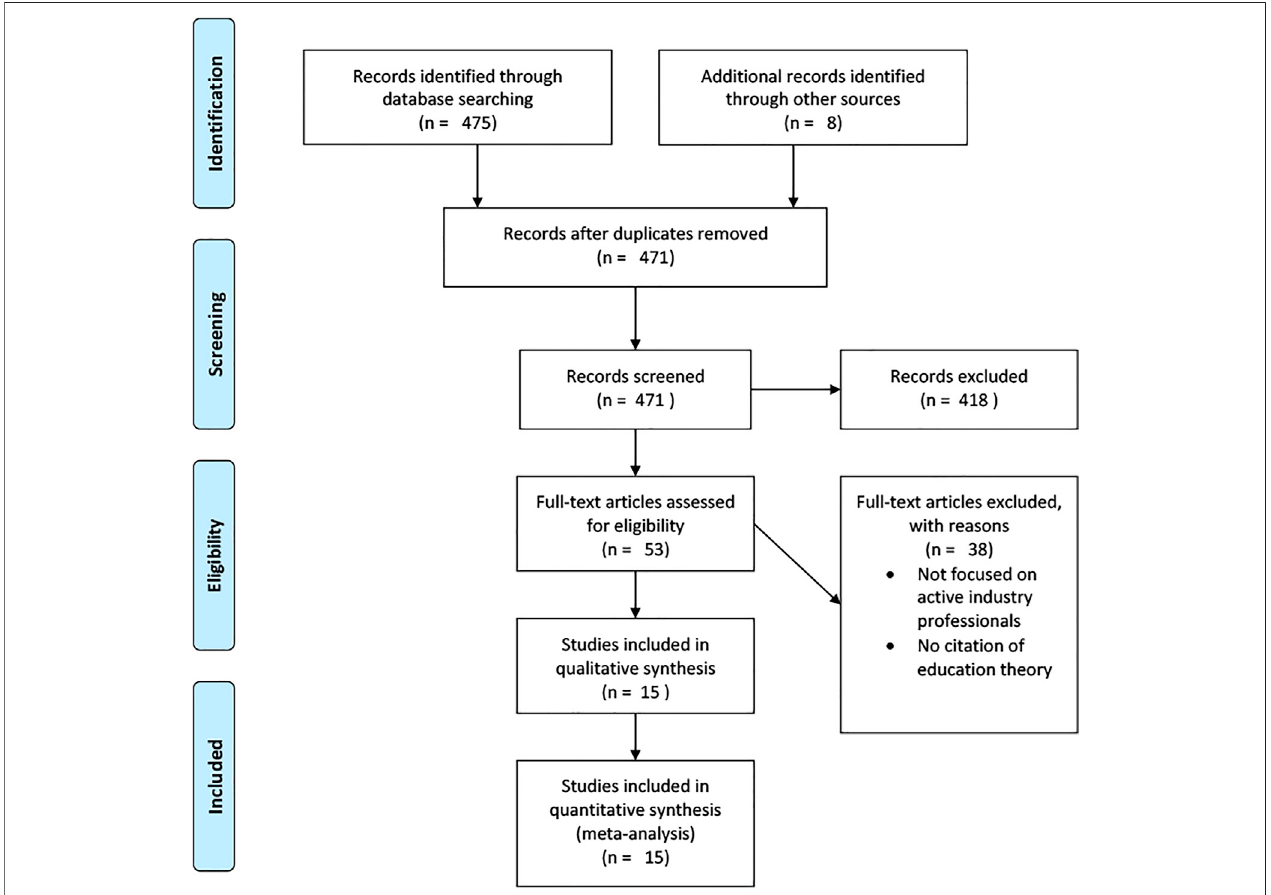
FIGURE 2 | PRISMA fl ow diagram of literature identi fi cation and selection process.